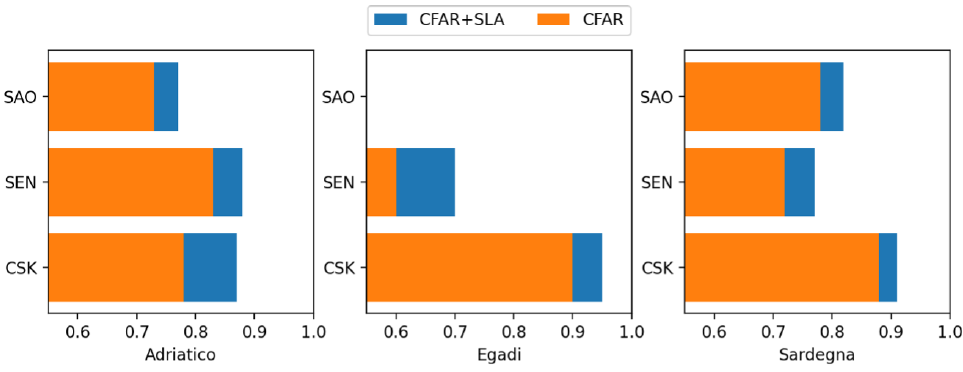
Figure 13. Comparative analysis of improved performance in terms of AUC for the considered sensors and the selected scenarios. CSK = COSMO-SkyMed, SAO = SAOCOM, and SEN =